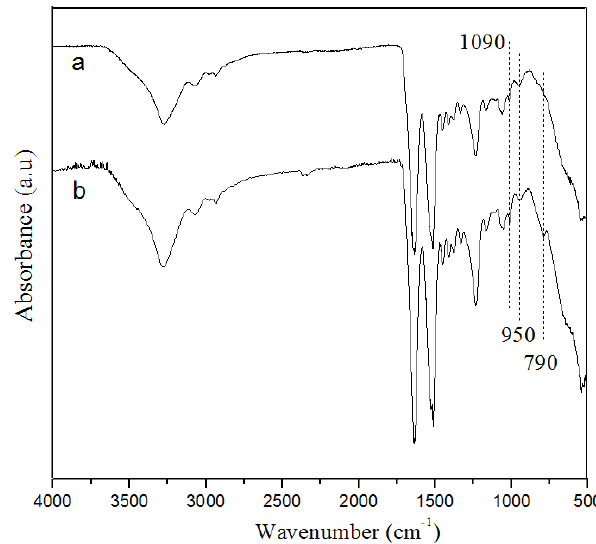
Figure 2. Fourier Transform Infrared (FTIR) spectra of: ( a ) pure silk nanofibers; and (b ) silk/TMOS nanofibers with TMOS concentration of 5 wt